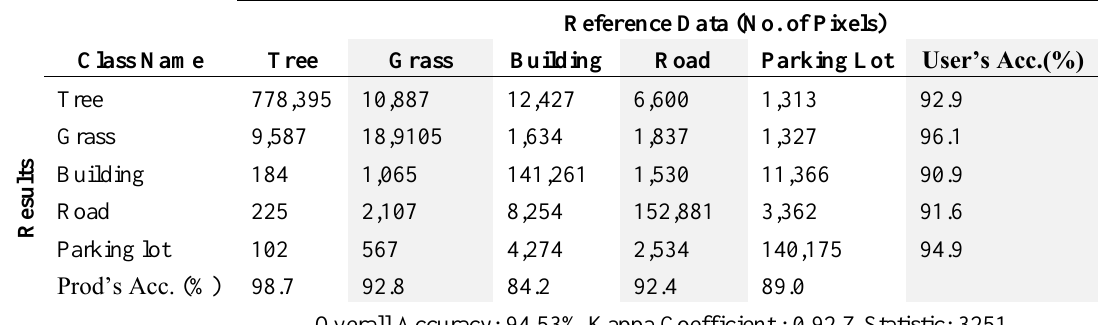
Table 3. Classification results for the QB-Pilot